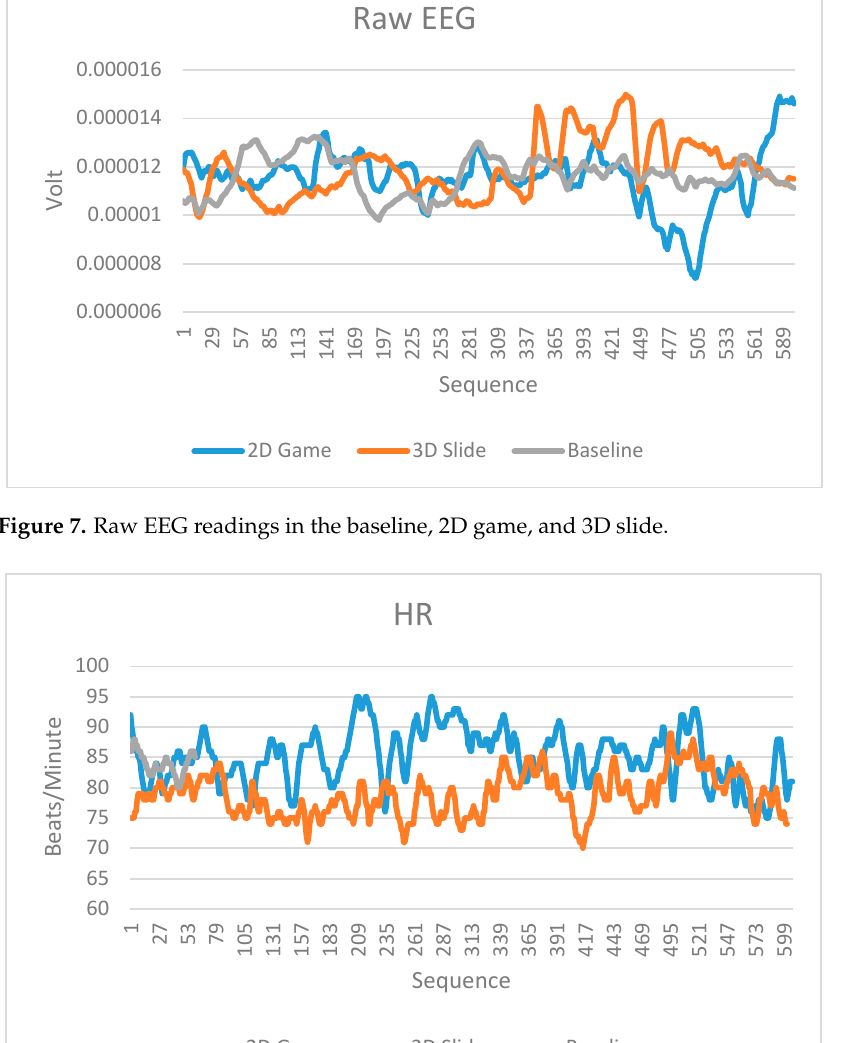
Figure 9. GSR readings in the baseline, 2D game, and 3D slide.